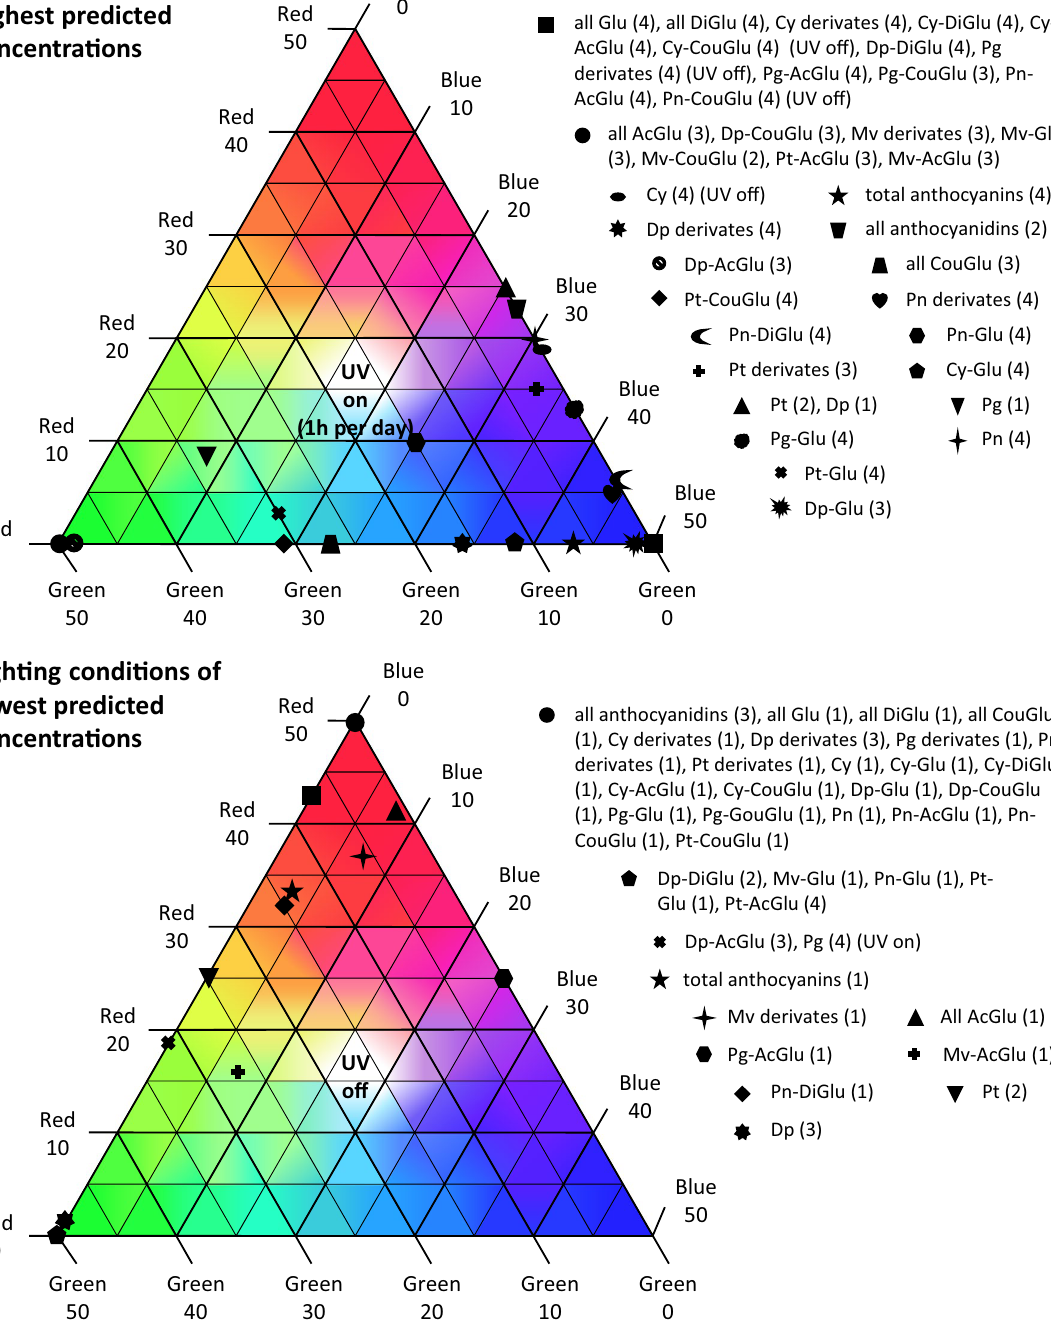
Figure 4. Optimal lighting conditions predicted to achieve the highest and lowest concentrations of each anthocyanin. Lighting conditions and concentrations were predicted using the Design-Expert tool “numerical optimization”, in which we chose a target (= anthocyanin or groups of anthocyanins) to maximize and minimize. Values were calculated based upon the previously generated RSMs. The color triangle represents the design space for the mixture design (red, green and blue), so every point on the triangle is a potential lighting condition within the ranges of the design. The numbers after the color (e.g. Red 50) specify the intensity of the light in µmol m −2 s −1 . Every point marked with a symbol represents the optimal lighting condition for the anthocyanin annotated with the same symbol. The number in brackets after the name of the anthocyanin is the cultivation time. “UV on/off” after the bracket means that for this anthocyanin the predicted UV level is different from the information within the triangle. The upper triangle shows the lighting conditions for upregulation and the triangle below shows the lighting conditions for